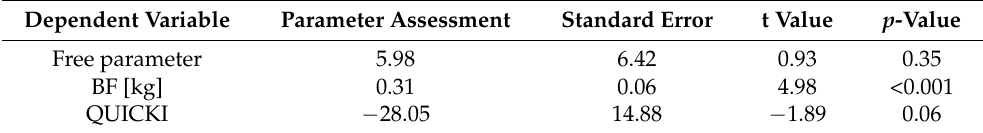
Table 6. Parameters of multiple regression model of the leptin (LEP) dependent